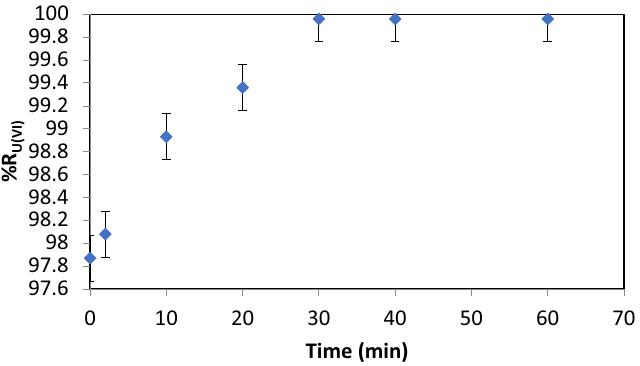
Figure 6. %R = f (contact time), V sample = 200 mL, stirring rate 250 RPM, pH = 8.75, [U(VI)] : [Fe (III)] : [NaOL] = 1 : 75 : 1 × 10 –2 , p = 4 × 10 5 N·m −2 , dilution ratio V sample : V water = 3 : 1